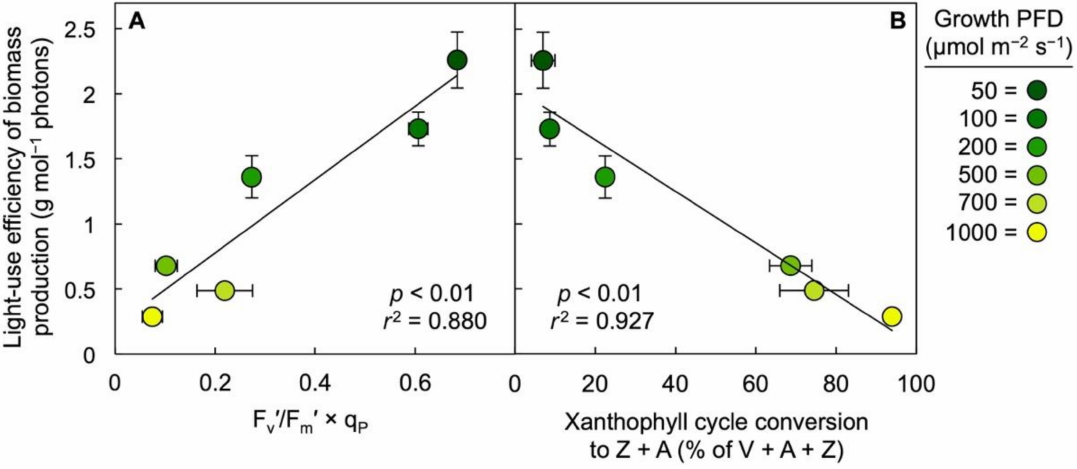
Figure 6. Correlations between the light-use efficiency of biomass production (total dry biomass produced per incident PFD during the four-day growth period) and ( A ) (F m (cid:48) − F)/F m (cid:48) = F v (cid:48) /F m (cid:48) × q P (as an estimate of the light-use efficiency of PSII photochemistry) or ( B ) the percent of the xanthophyll cycle pool converted to zeaxanthin (Z) and antheraxanthin (A) in Lemna gibba fronds grown under six PFDs ranging from 50 to 1000 µ mol m − 2 s − 1 . Mean values ± standard deviations, n = 3 or 4. Data for PFDs of 100 to 700 µ mol m − 2 s − 1 were calculated from [2]. V = violaxanthin.